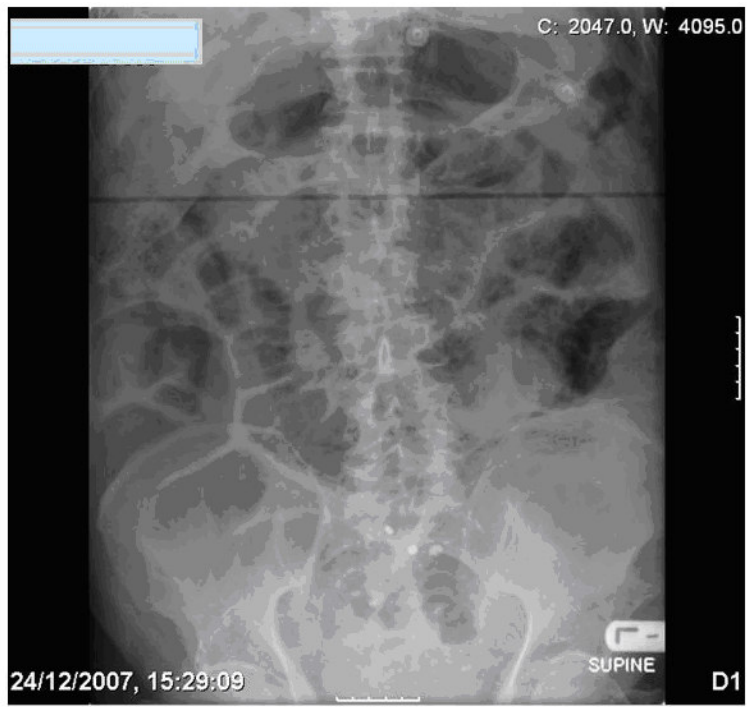
FIGURE 2. Abdominal X-ray showing dilated small and large bowels. The small bowel wall appears thickened.